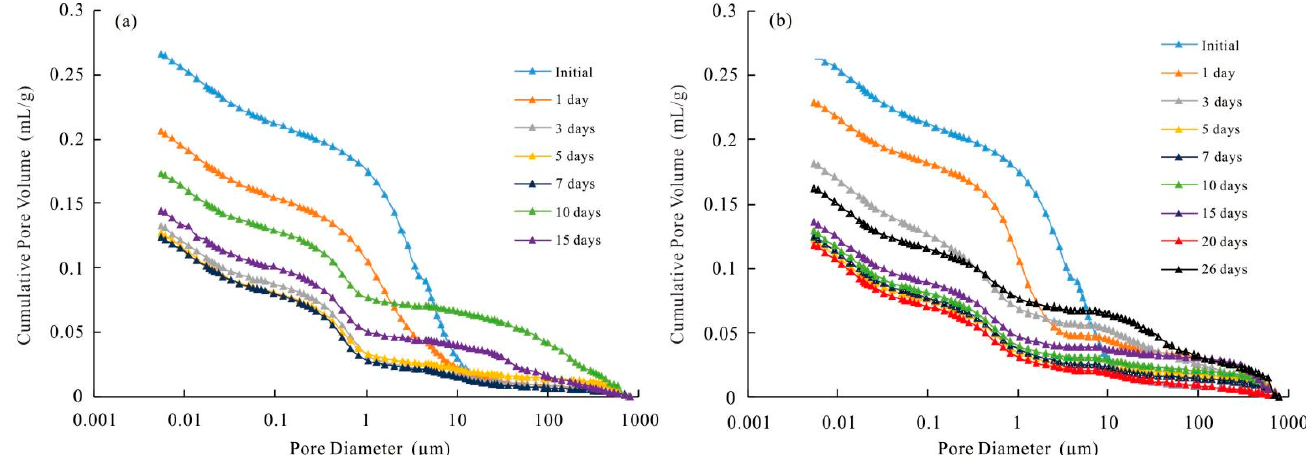
Figure 4. The relationship between the cumulative pore volume distribution and the dehydration time of expansive soil under different environmental conditions ( a ) 50 °C-10%, ( b ) 50 °C-70%.